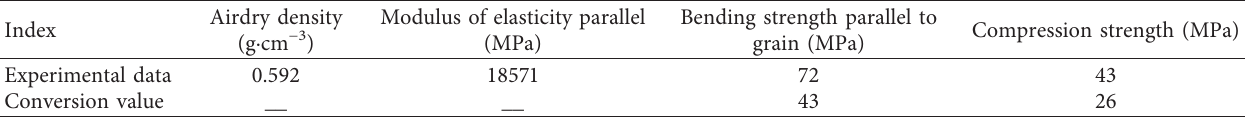
Table 2: Material properties of wood.